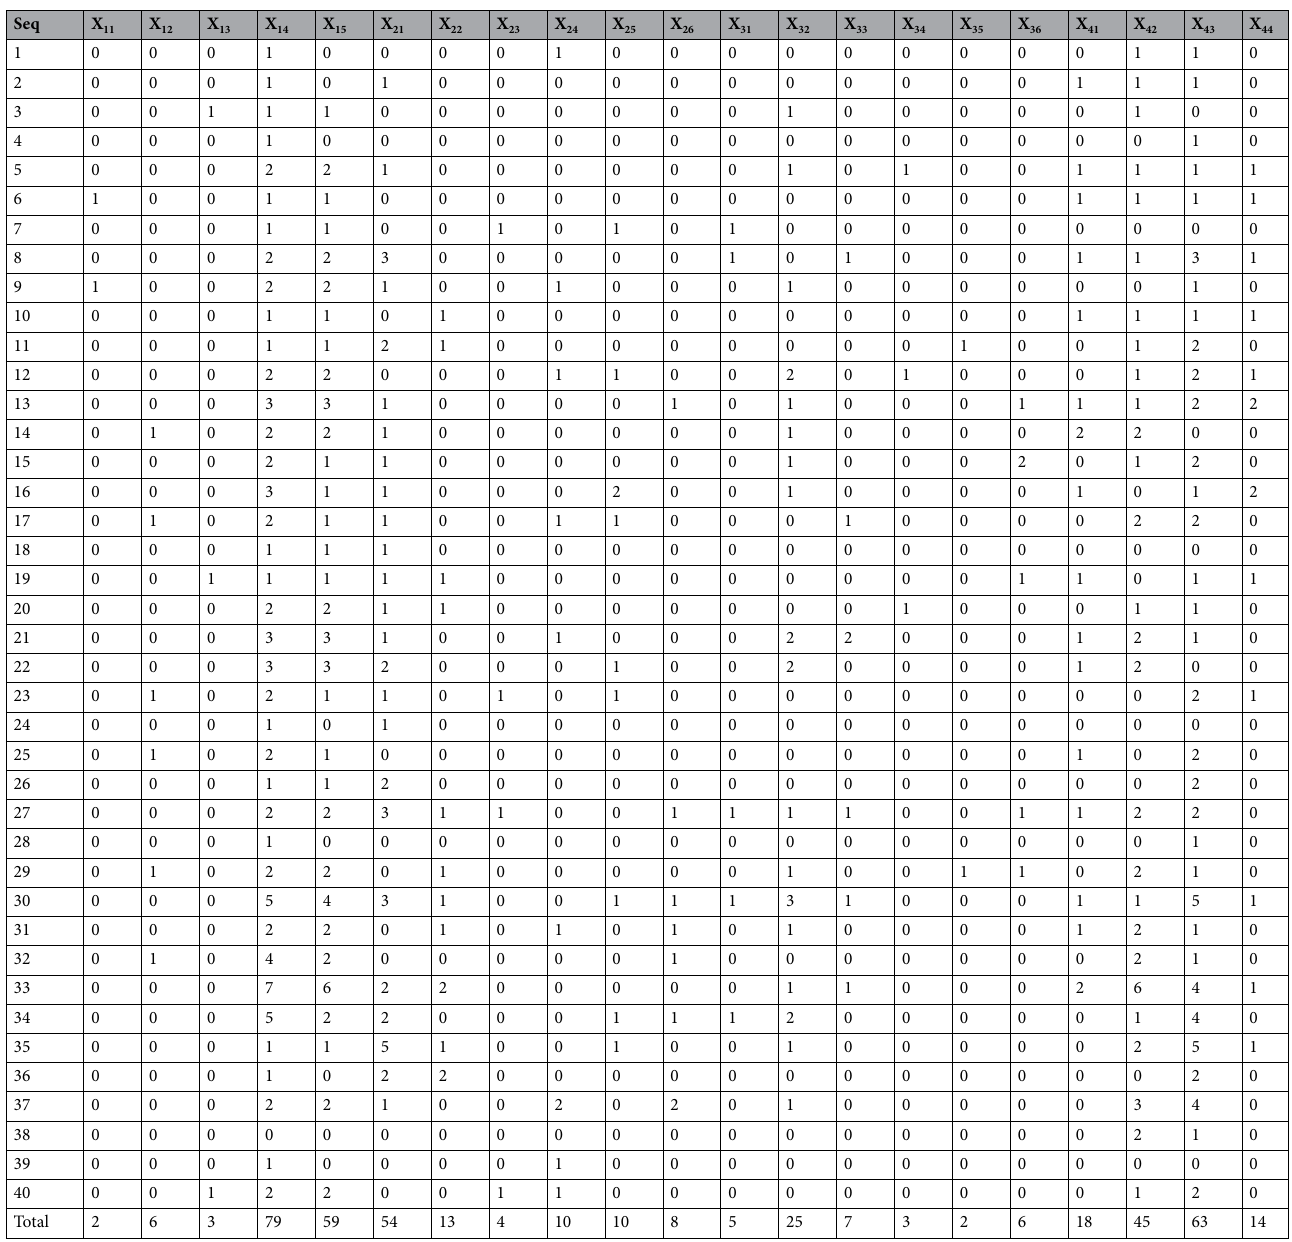
Table 3. Cumulative eigenvalues of bottom causal